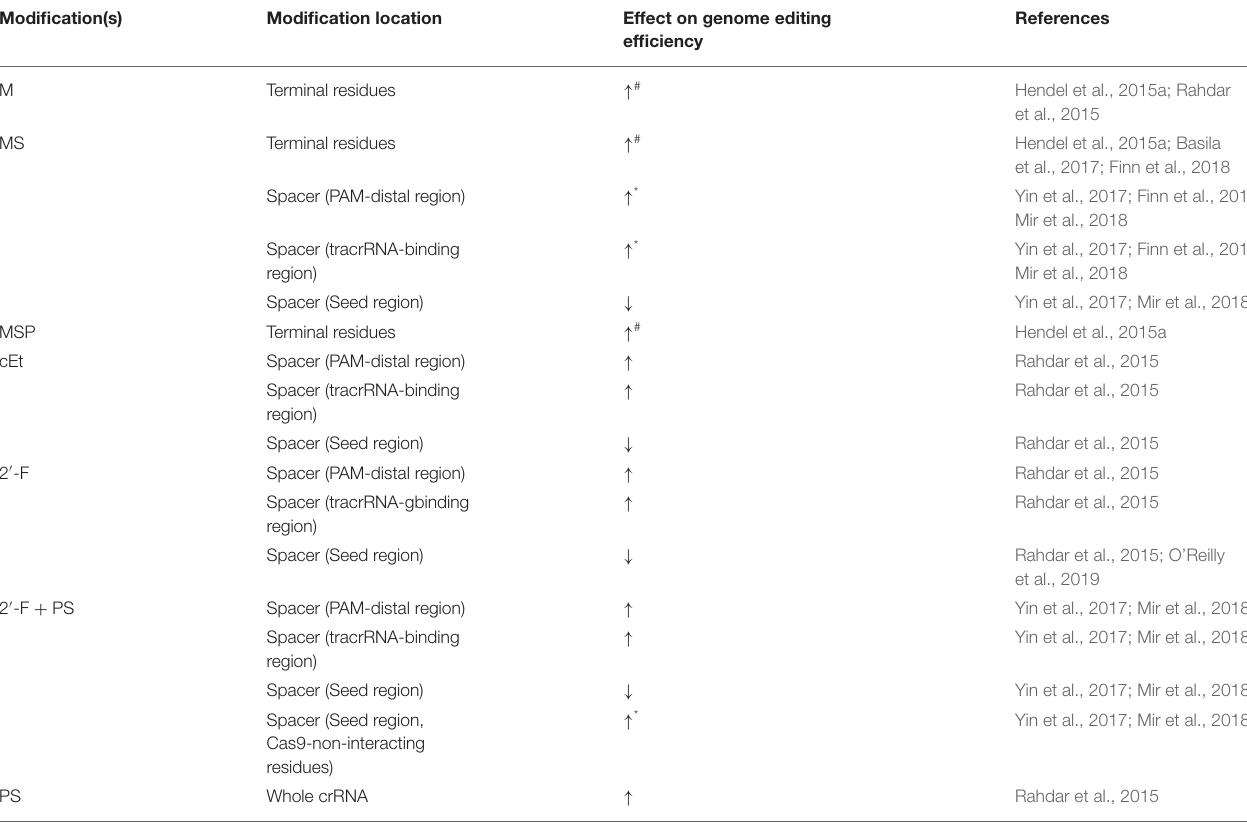
TABLE 1 | gRNA modifications to improve CRISPR-Cas9 efficiency in cultured mammalian